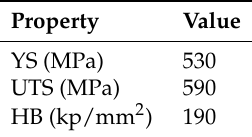
Table 4. Al 7010-T6’s aluminum alloy mechanical properties.